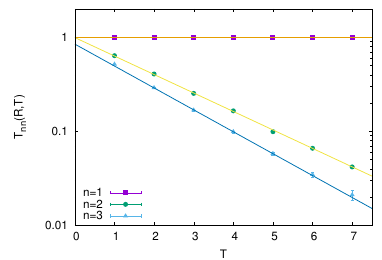
Figure 3. T nn ( R , T ) vs. T at R = 5 . 83, for n = 1 , 2 , 3 together with their best fits. The corresponding energies E n ( R ) are ex- tracted from the slope of exponential fits on a log plot. This data was obtained on a 12 3 × 36 lattice volume at β = 10 . 9 and γ = 0 . 60.